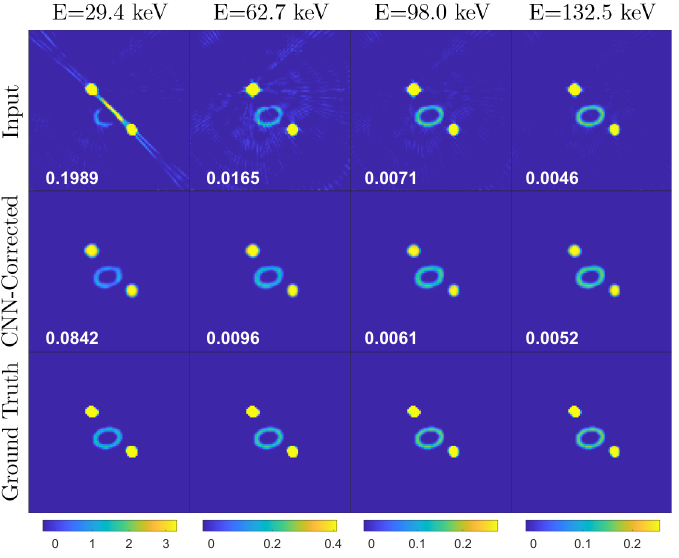
Figure 6. Simulation test data. Example 2: the object feature obscured by the metal-provoked streak artifact is restored by the CNN correction. (Layout as in Figure